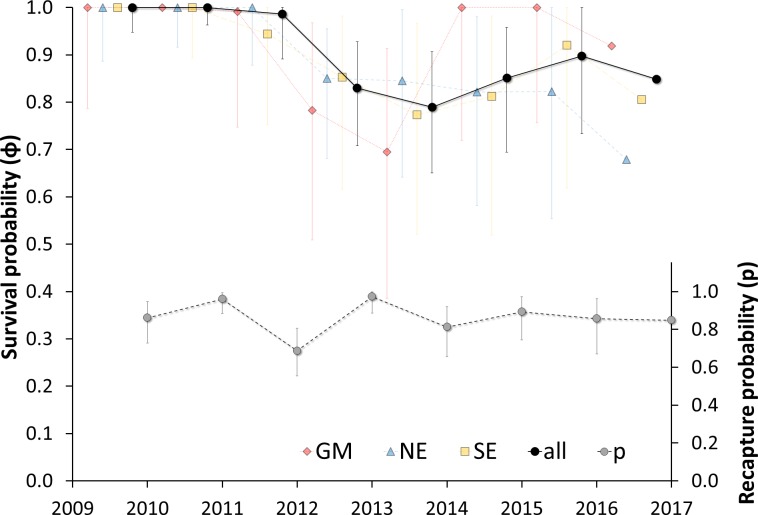
Annual survival rates of Northern Gannets nesting on Bonaventure Island, Canada, and wintering in the Gulf of Mexico (GM), southeast coast of the U.S. (SE), northeast coast of the U.S. (NE) and all individuals together from 2009 to 2017.Survival rates for GM, SE and NE were calculated from the model ɸg*t pt. and recapture probability (p) were calculated from the best fit model: ɸt pt (see Table 2). Lines for sites are presented separately just to display the absence of difference, but they are faded because wintering sites are not in the best model (see Table 2). Bars are showing the 95% CI (estimated from profile likelihood method) around the mean annual survival.